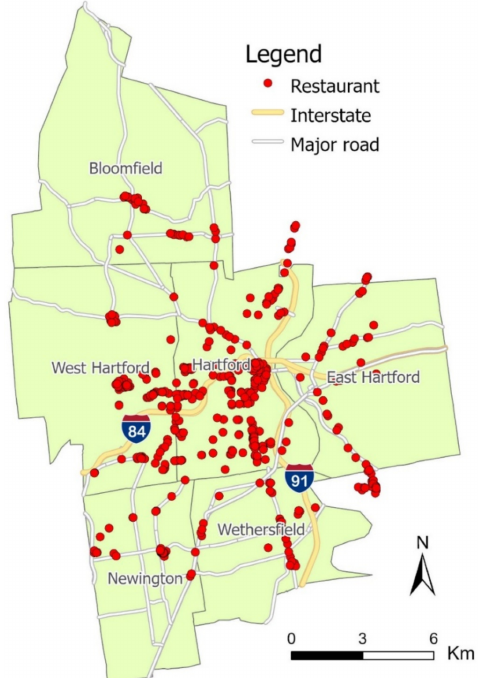
Figure 1. Spatial distribution of restaurants in the study